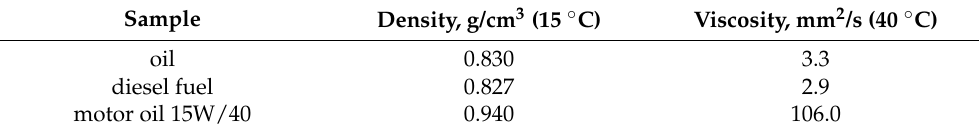
Table 1. Physical characteristics of oil